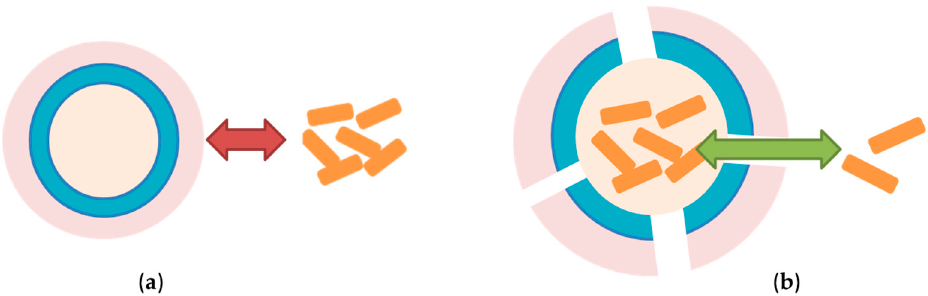
Figure 6. Schematic diagram of CM state before ( a ) and after PEF treatment ( b ), as well as respective interaction with β -carotene molecules.